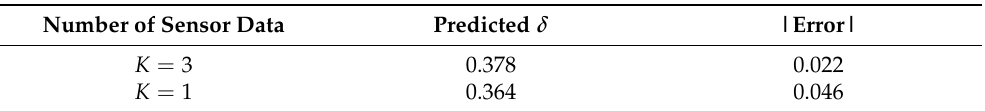
Table 5. The inverse problem parametric PBA-PINN (20) solving results. Predicted parameter δ values for different sensor data numbers and ground-truth value δ = 0.4 .